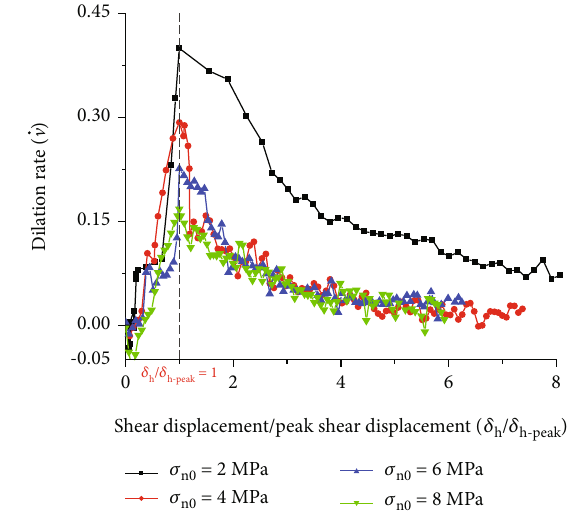
Figure 9: Curves of the dilation rate with λ